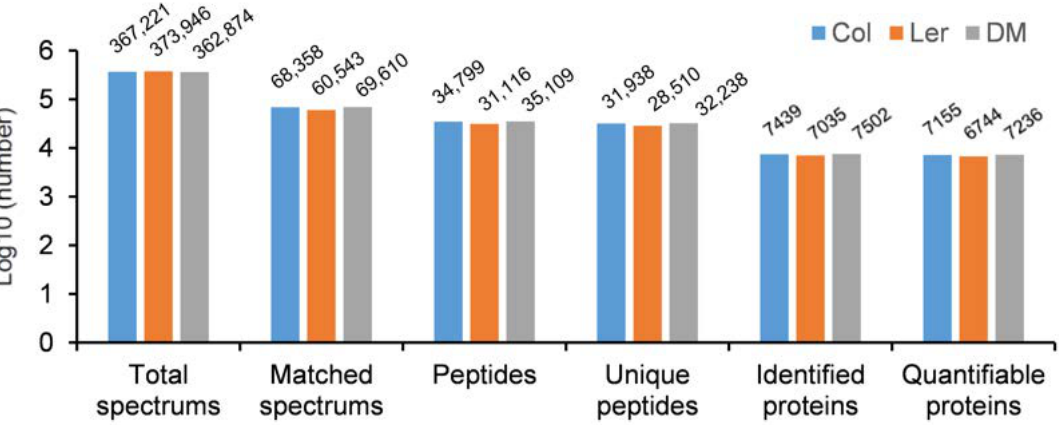
Figure 3. An overview of protein identifications in Col, L er , and DM plants. Wild-type Col and L er plants were grown on 1 MS plates for 9 days, and then seedlings were treated without or with 5 µ g / mL 2 tunicamycin (TM) for 12 h. Total proteins were extracted from the whole seedlings for TMT-based quantitative proteomics analysis. The bzip28 bzip60 double mutant (DM) plants in the Col background was used as a control.